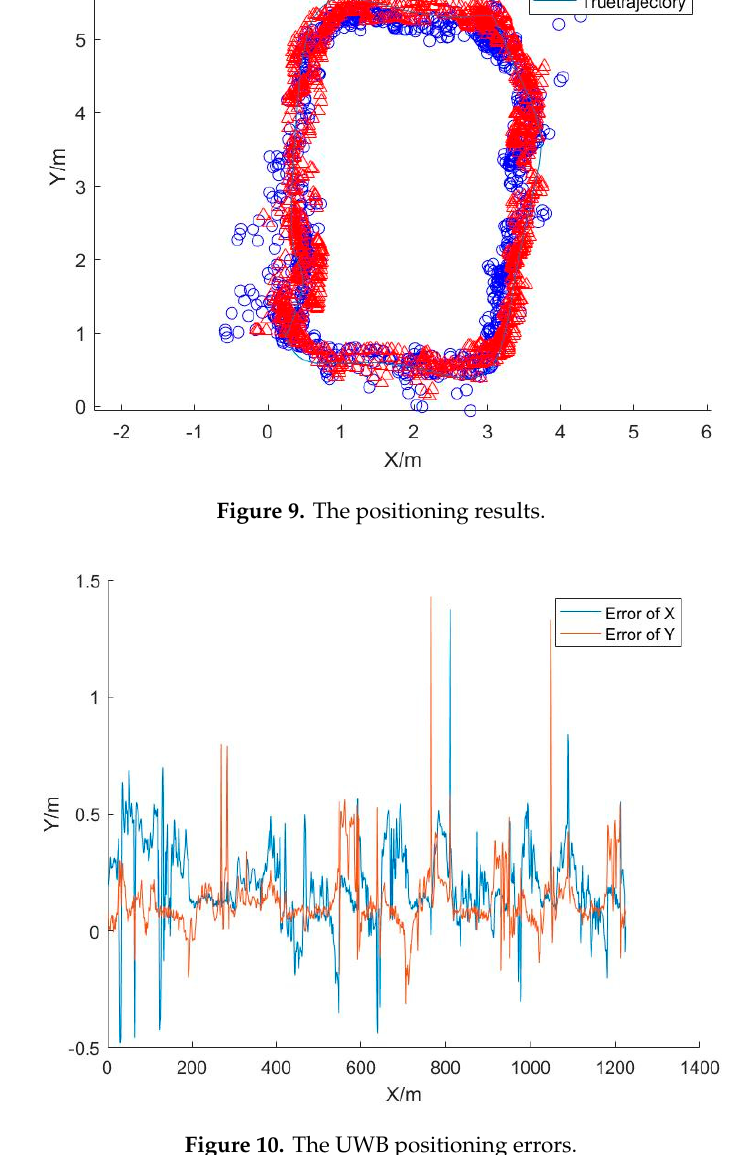
Figure 10. The UWB positioning errors.